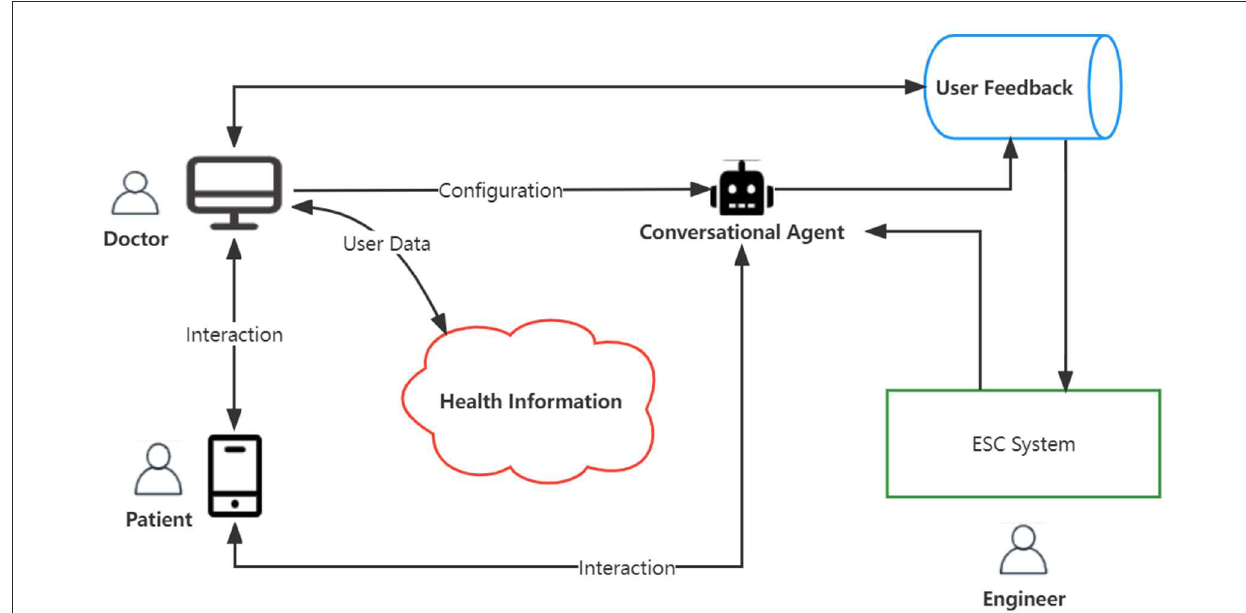
FIGURE1 Digital therapeutics platform with the model of emotional support